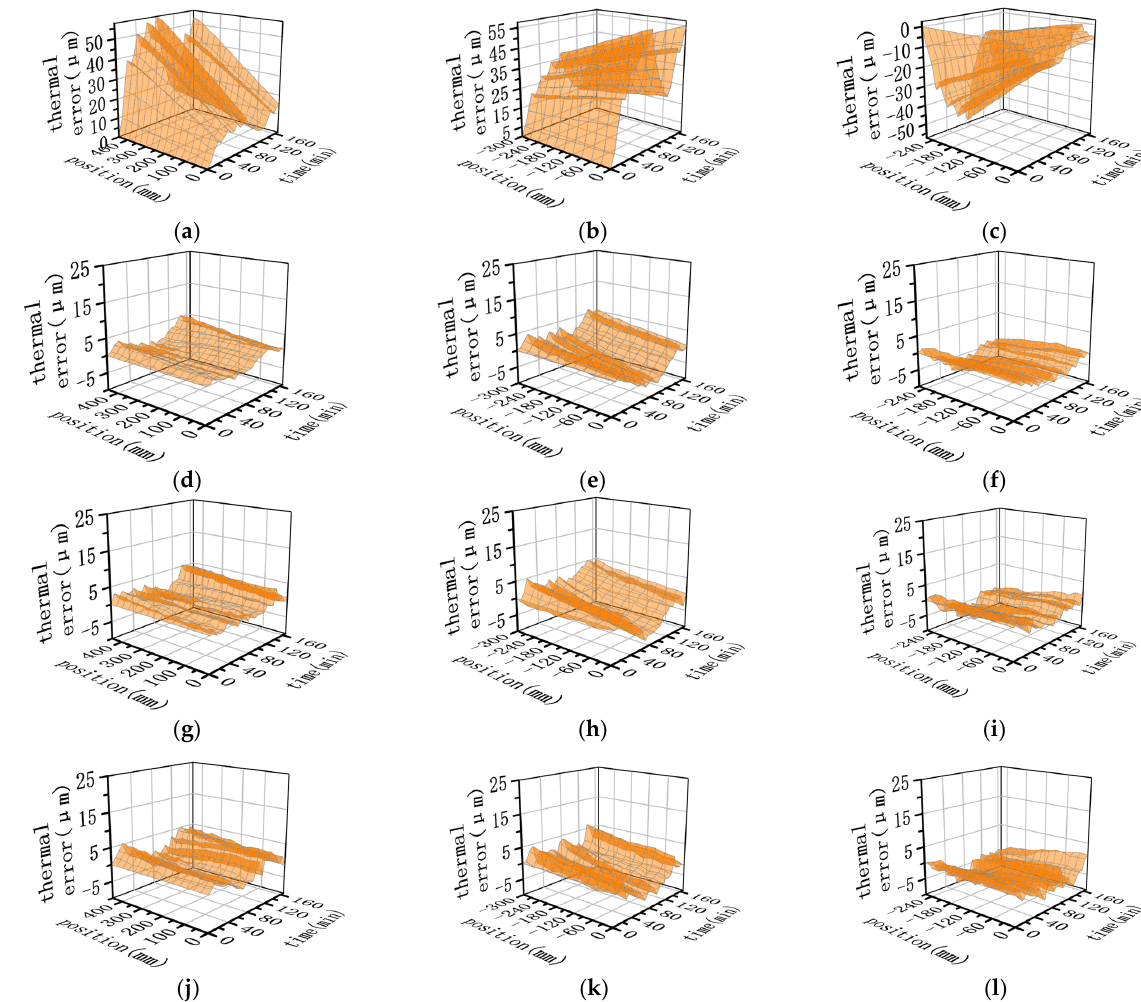
Figure 13. Measured positioning thermal error. ( a ) X-axis without compensation. ( b ) Y-axis without compensation. ( c ) Z-axis without compensation. ( d ) X-axis with compensation (1st). ( e ) Y-axis with compensation (1st). ( f ) Z-axis with compensation (1st). ( g ) X-axis with compensation (2nd). ( h ) Y-axis with compensation (2nd). ( i ) Z-axis with compensation (2nd). ( j ) X-axis with compensation (3rd). ( k ) Y-axis with compensation (3rd). ( l ) Z-axis with compensation (3rd).